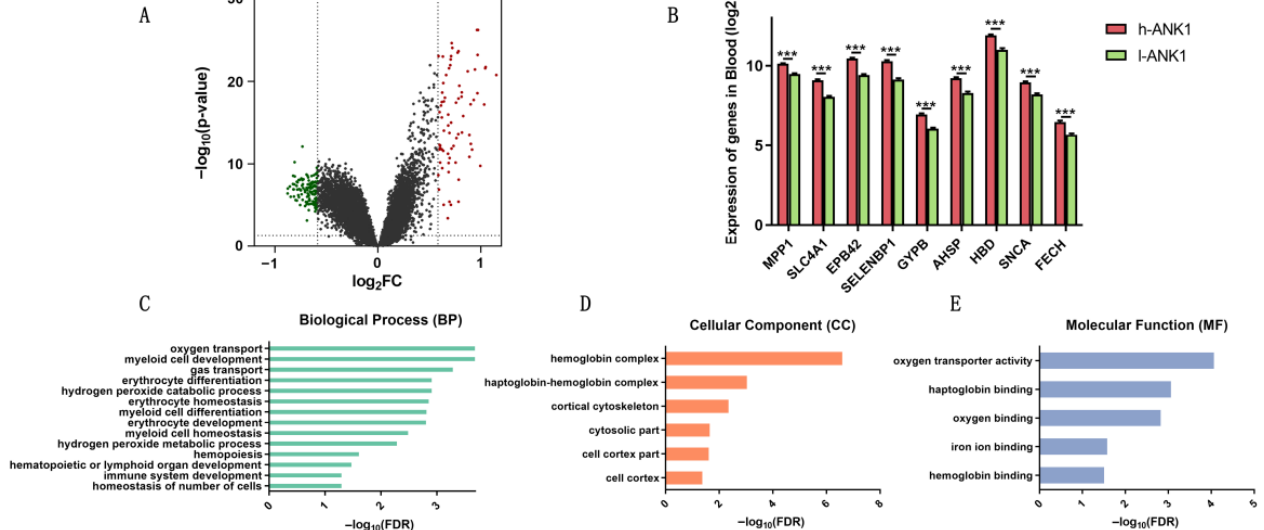
Figure 3. ANK1 was associated with PD. ( A ) DEGs were extracted from GSE 99039 according to the median value of ANK1 . Volcano plot of differential gene profiles between h- ANK1 and l- ANK1 group is shown. ( B ) PD biomarkers exhibited differential expression between h- ANK1 and l- ANK1 group. Based on ANK1 expression level (high vs. low), the study analyzed the DEGs via function enrichment analysis. The enriched biological process (BP) ( C ), cellular component (CC) ( D ) and molecular function (MF) ( E ) terms are presented. Data are expressed as mean ± S.E.M. Two groups were analyzed by Student’s t -test. *** p < 0.01.